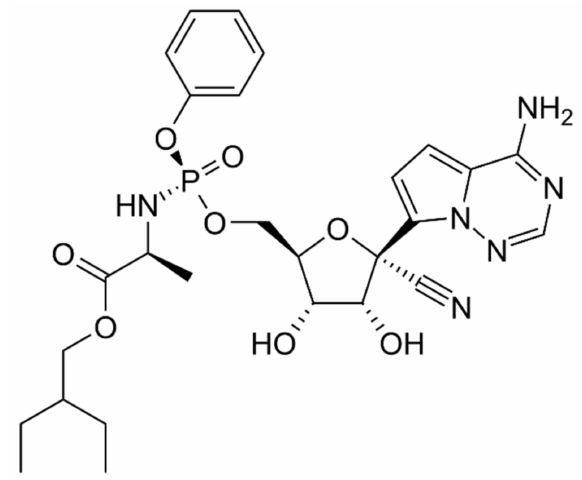
Figure 15. Structure of Remdesivir.